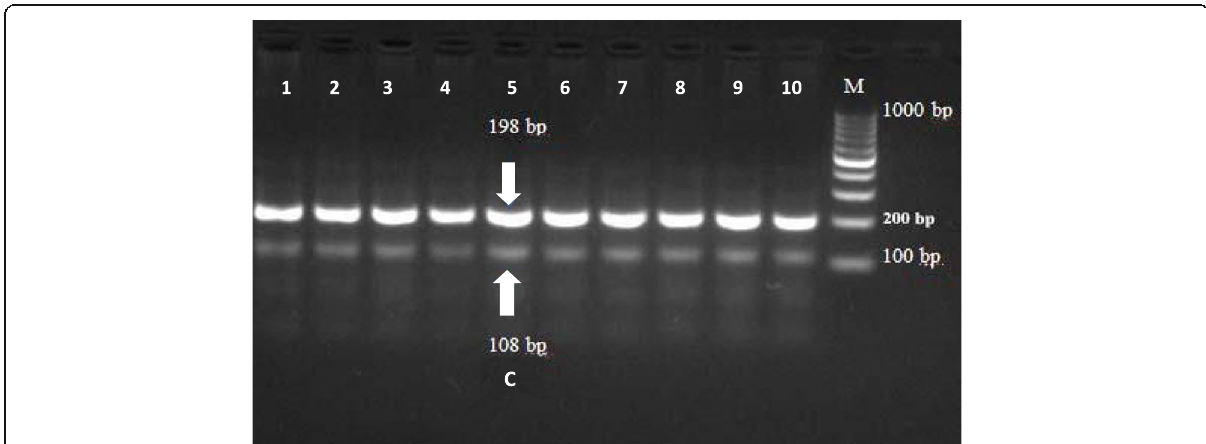
Fig. 5 Electrophoresis of agarose gel (2%) of polymerase chain reaction (PCR) product of tetra-primer amplification refractory mutation system- PCR for G8 locus of GDF9 gene in sheep and goats. The Lanes of 1 to 10: Amplification of common outer product (198 bp) and allele-specific wild type (108 bp) are indicated by an arrow of the respective gel photograph. Lane M: DNA molecular weight marker (O` Range Ruler 100 bp DNA Ladder, Fermentas, Lithuania). C = wild type